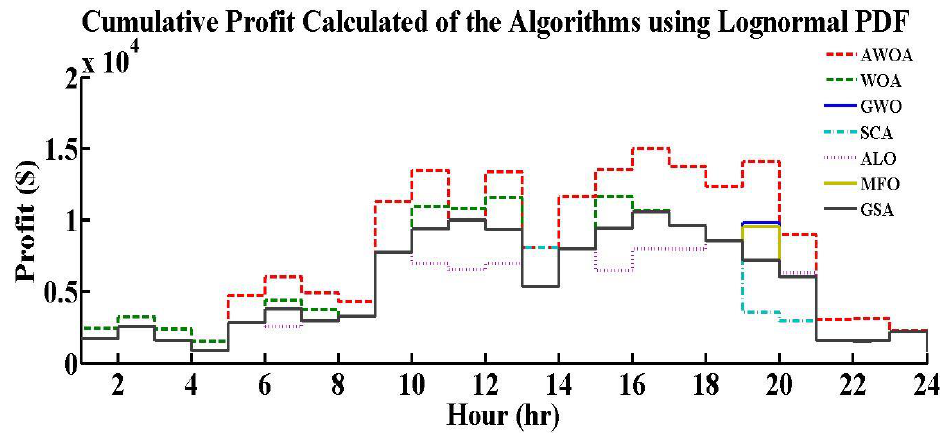
Figure 12. Cumulative Profit Calculated of the Algorithms using Lognormal PDF.